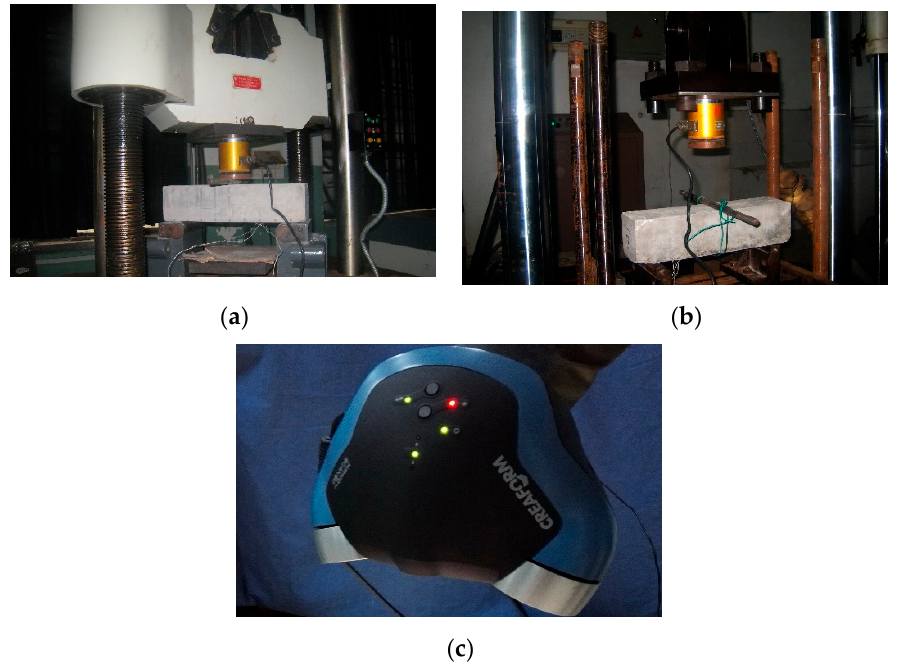
Figure 2. Experimental setup. ( a ) CSS200 Universal Material Testing Machine, ( b ) FDS300 Fatigue Testing Machine and ( c ) 3D laser scanner, Handy SCAN .